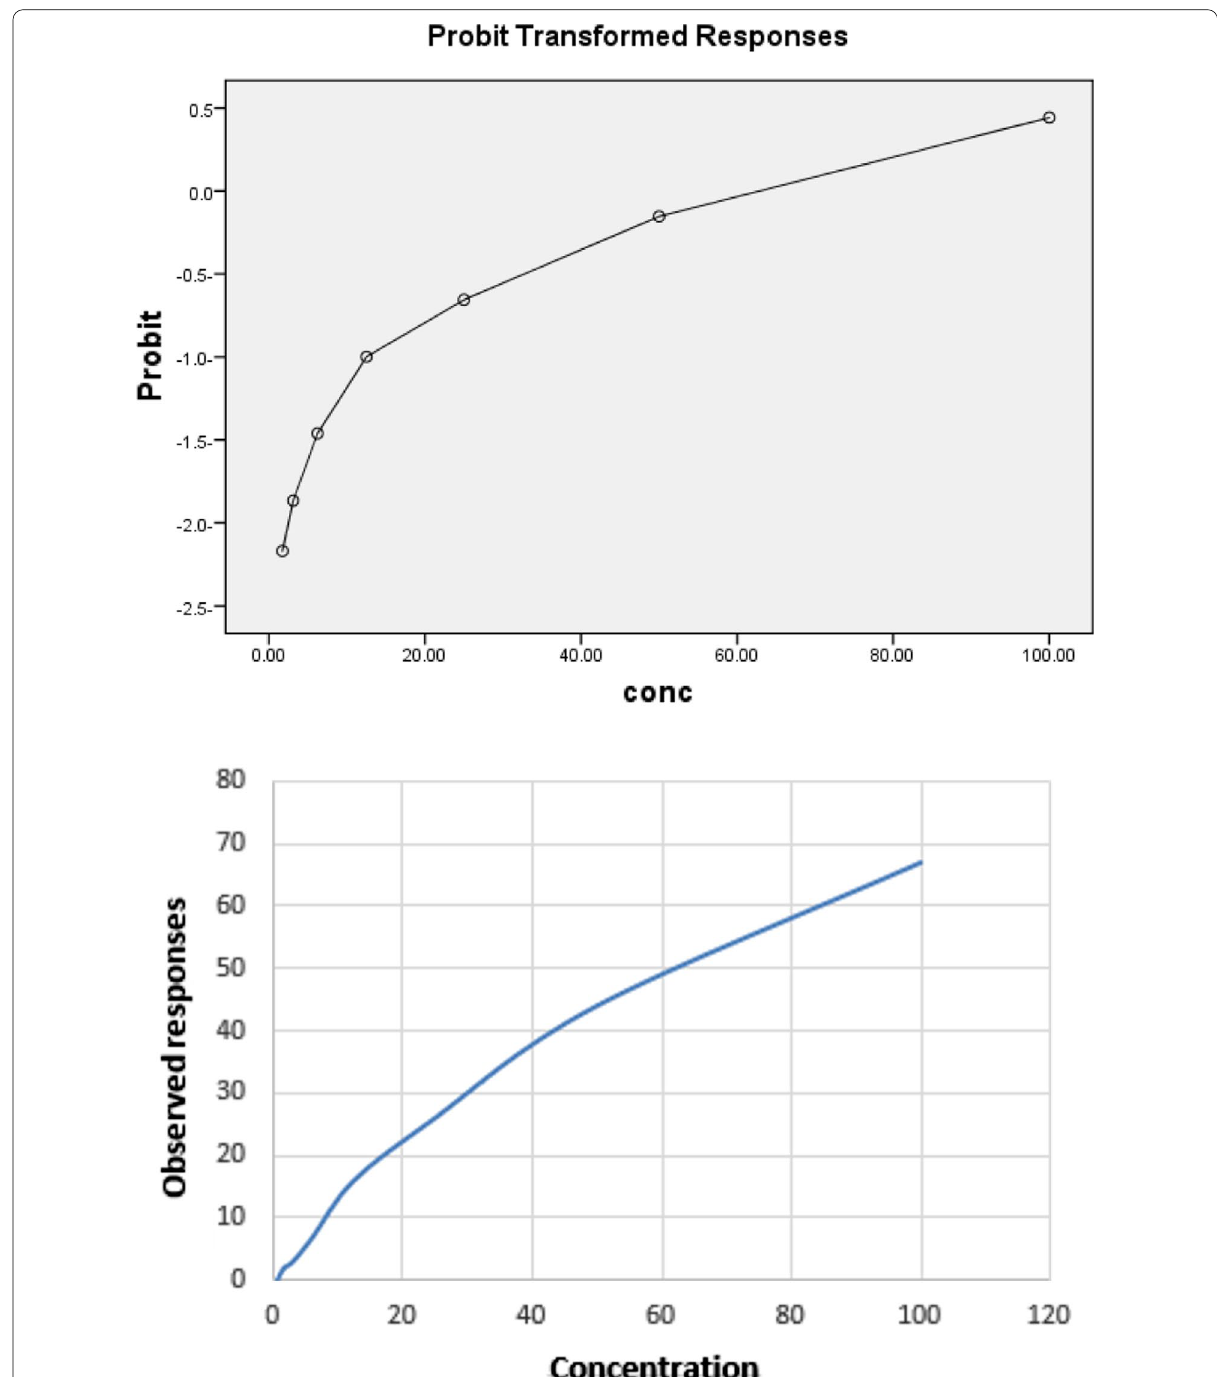
Fig. 2 Antioxidant activity of the methanolic extract of S. mahagoni (L.)